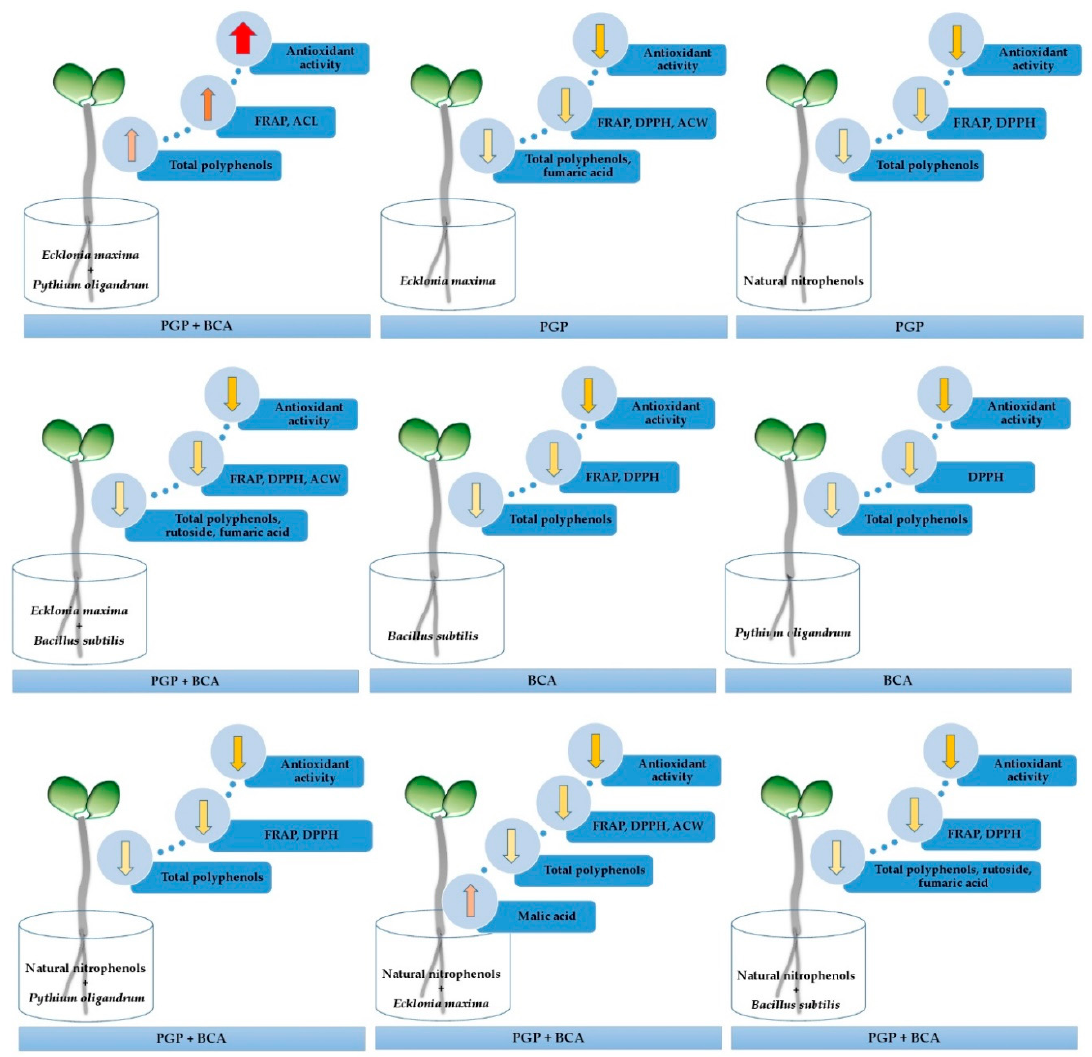
Figure 4. A possible mode of action of plant growth promoters (PGPs) and biological control agents (BCAs) influence on the chemical composition and antioxidant activity of buckwheat sprouts. FRAP—Ferric Reducing Antioxidant Power; DPPH (1,1-diphenyl-2-picrylhydrazyl)—free radical scavenging method for evaluation the antioxidant activity of compounds able to transfer hydrogen atoms; ACL—Lipid-Soluble Antioxidant Capacity; ACW—Water-Soluble Antioxidant Capacity. Up/down arrows indicate an increase/decrease of measured parameters comparing with untreated seeds (control).